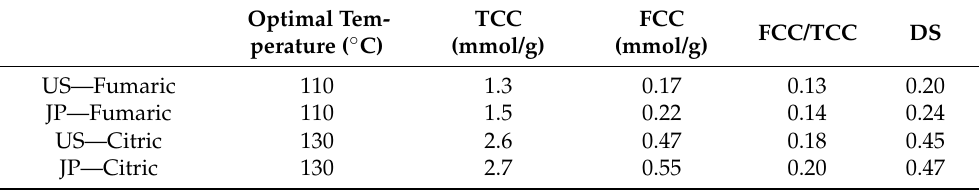
Table 2. Optimal temperature, total carboxyl groups content (TCC), free carboxyl groups content to total carboxyl groups content ratio, and degree of substitution determined for samples treated with fumaric and citric acid for 45